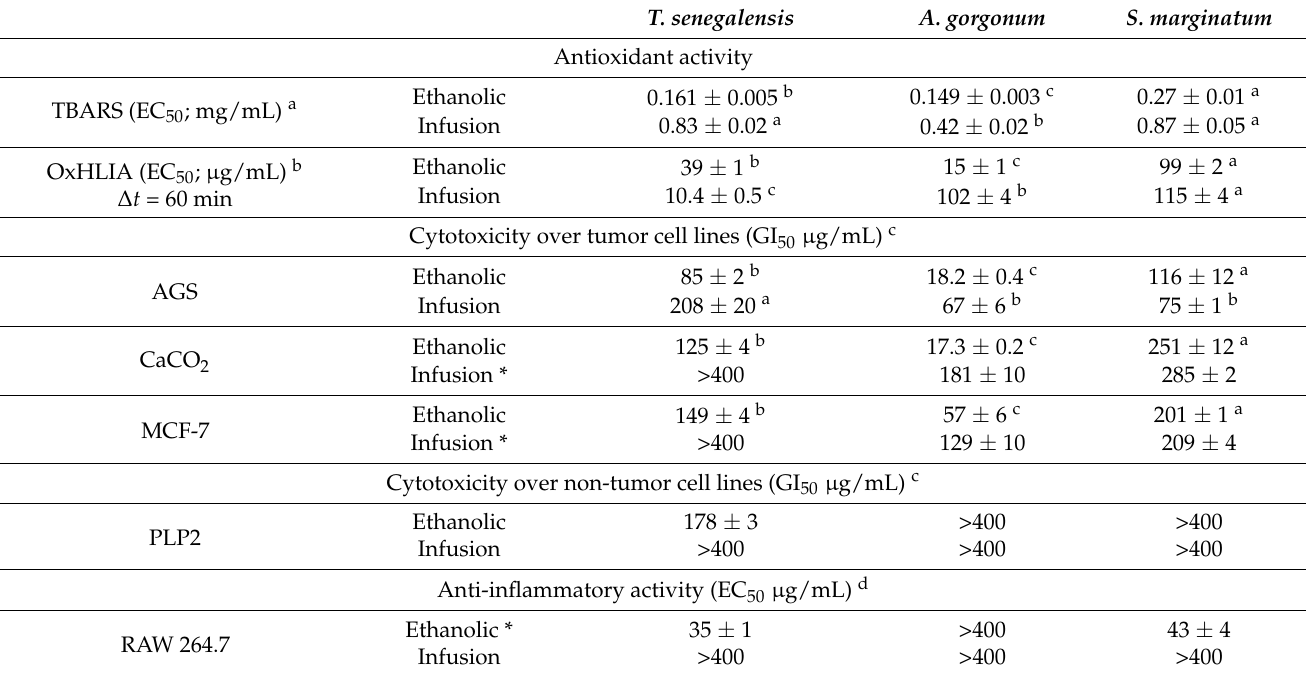
A. gorgonum , and S. marginatum ethanolic extracts and infusion preparations (mean ± SD, n =